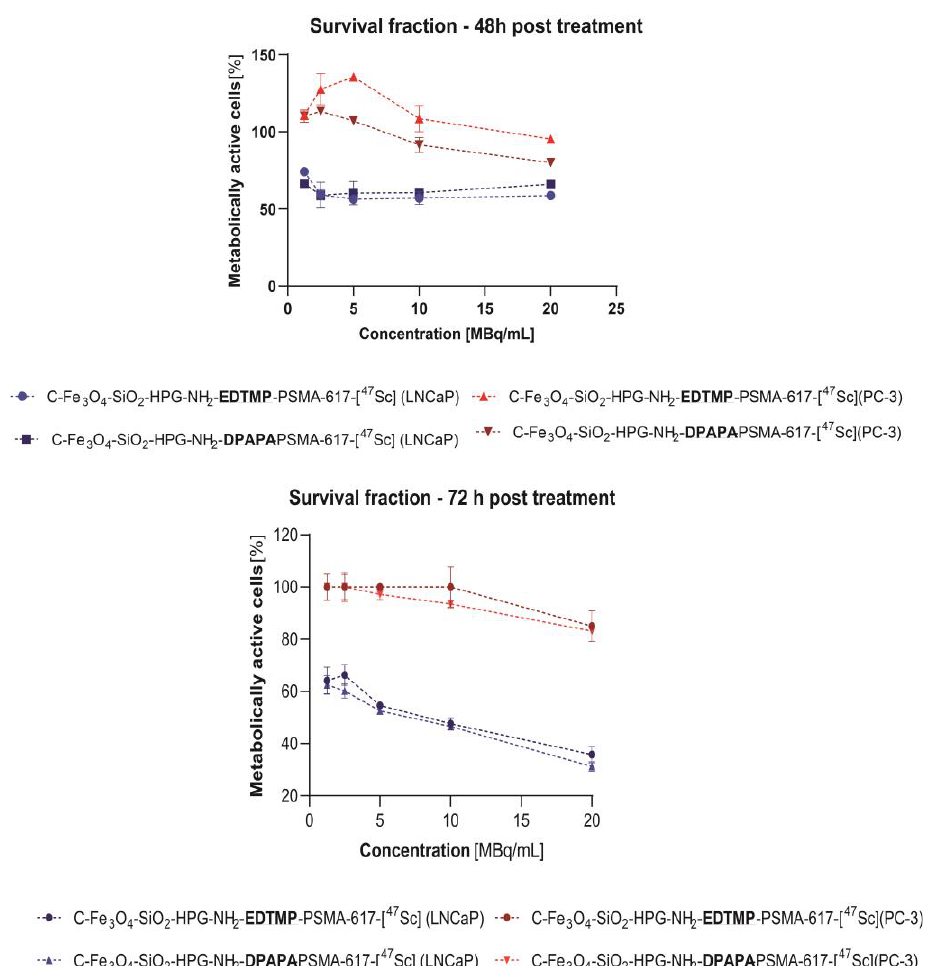
Figure 7. Cell viability of LNCaP and PC-3 cells treated with radiobioconjugates.